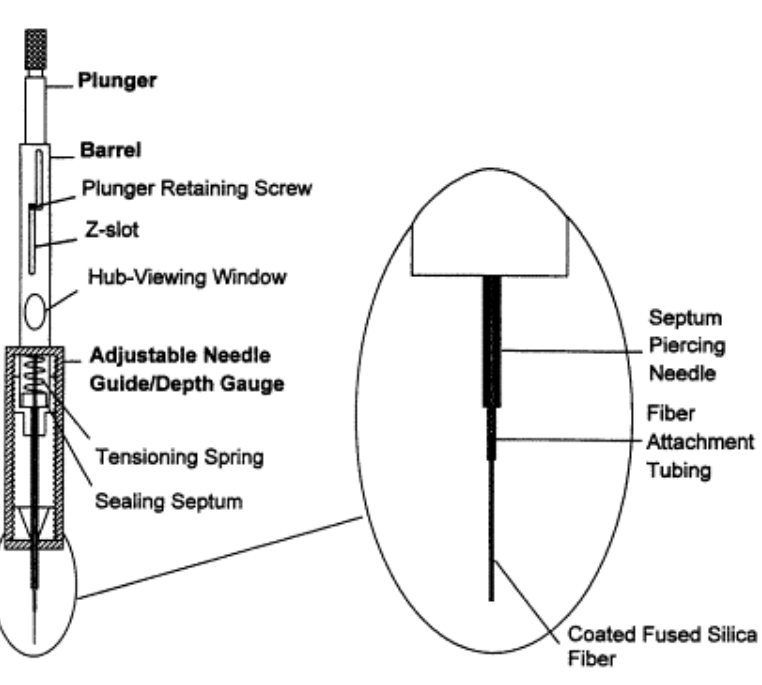
FIGURE 5. Schematics of SPME manual